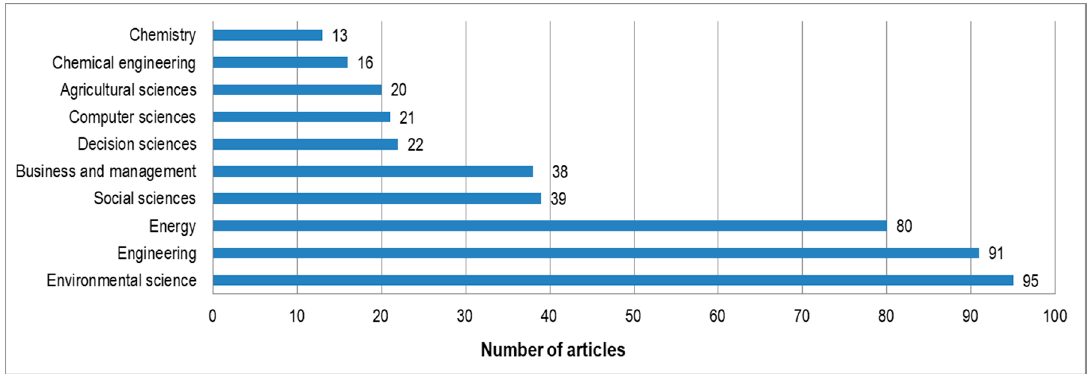
Figure 1. Classification of articles considering subject areas based on search in Scopus database using “energy efficiency” AND “logistics” keywords.